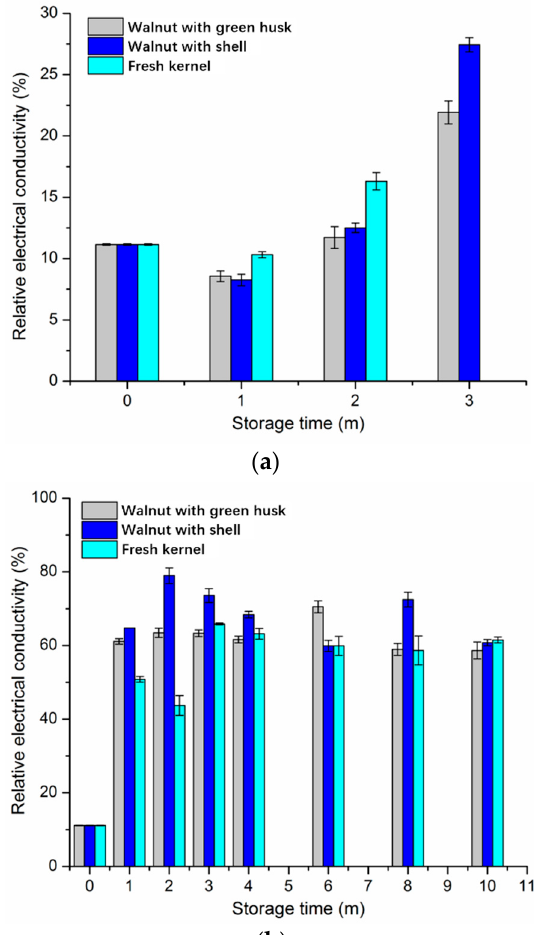
Figure 2. Relative electrical conductivity of walnut kernels under different storage conditions: ( a ) 0 °C and ( b ) − 20 °C. Note: m means month in the figure. Data of fresh kernel stored at 0 °C are not available due to the limited shelf life.